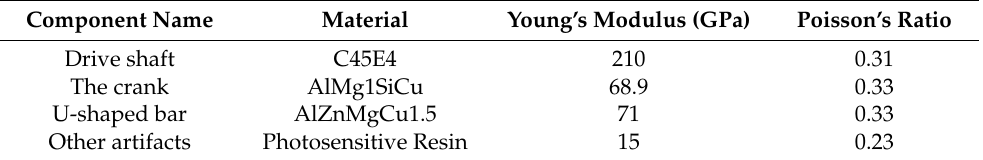
Figure 15. Foot simulation trajectory.